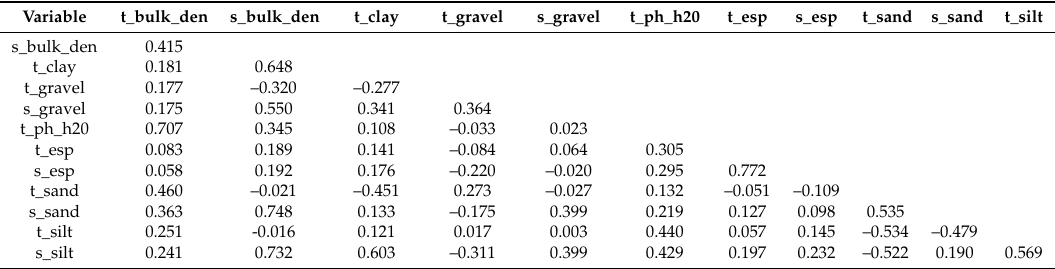
Table A4. Pearson correlation coefficients ( r ) among 12 soil variables calculated using the Band Collection Statistics tool in ArcGIS